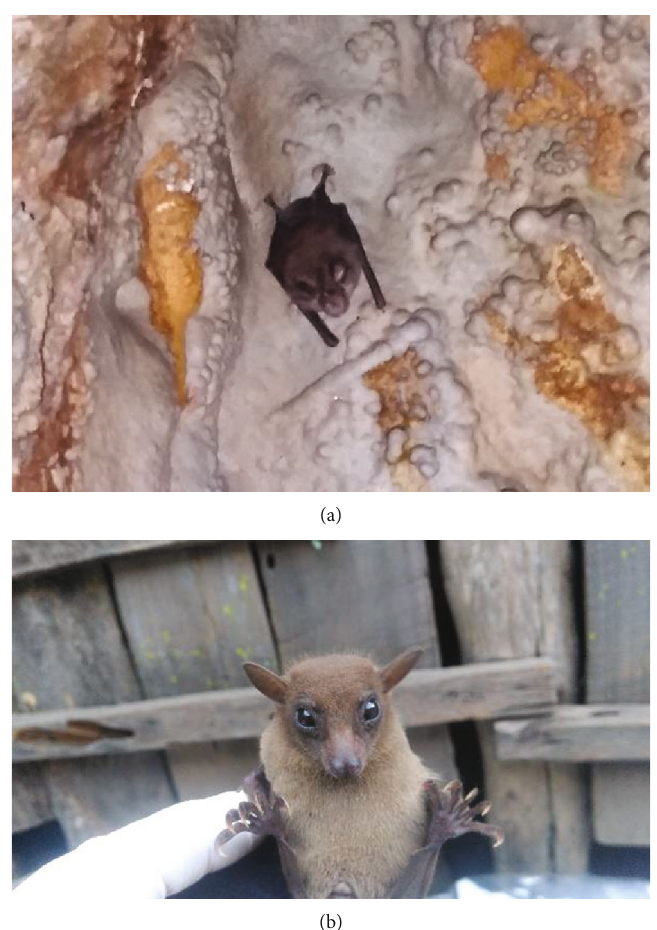
Figure 2: (a) Photograph of an insectivorous bat in the tunnel. (b) Photograph of a frugivorous